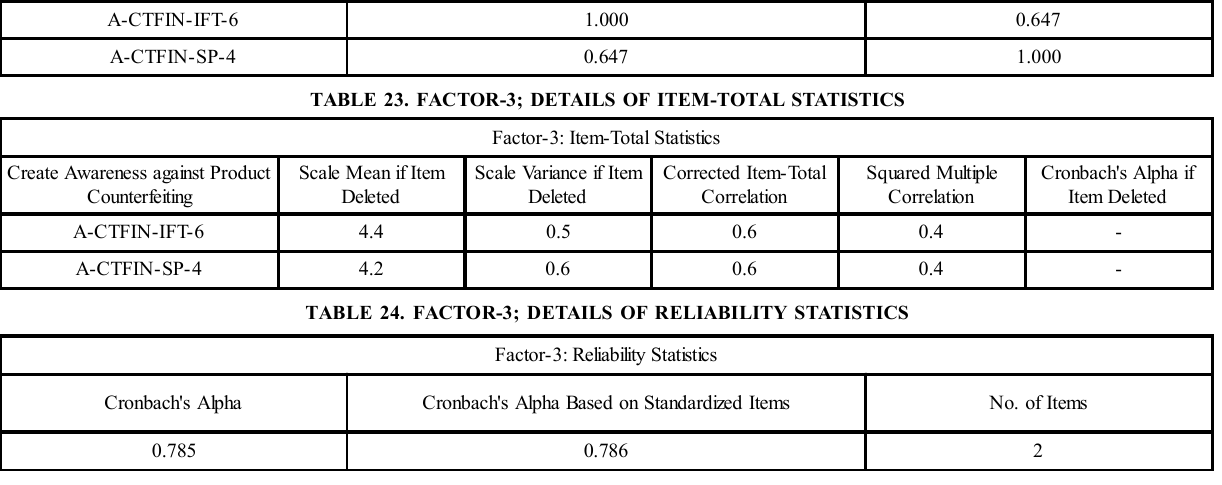
TABLE 23. FACTOR-3; DETAILS OF ITEM-TOTAL STATISTICS